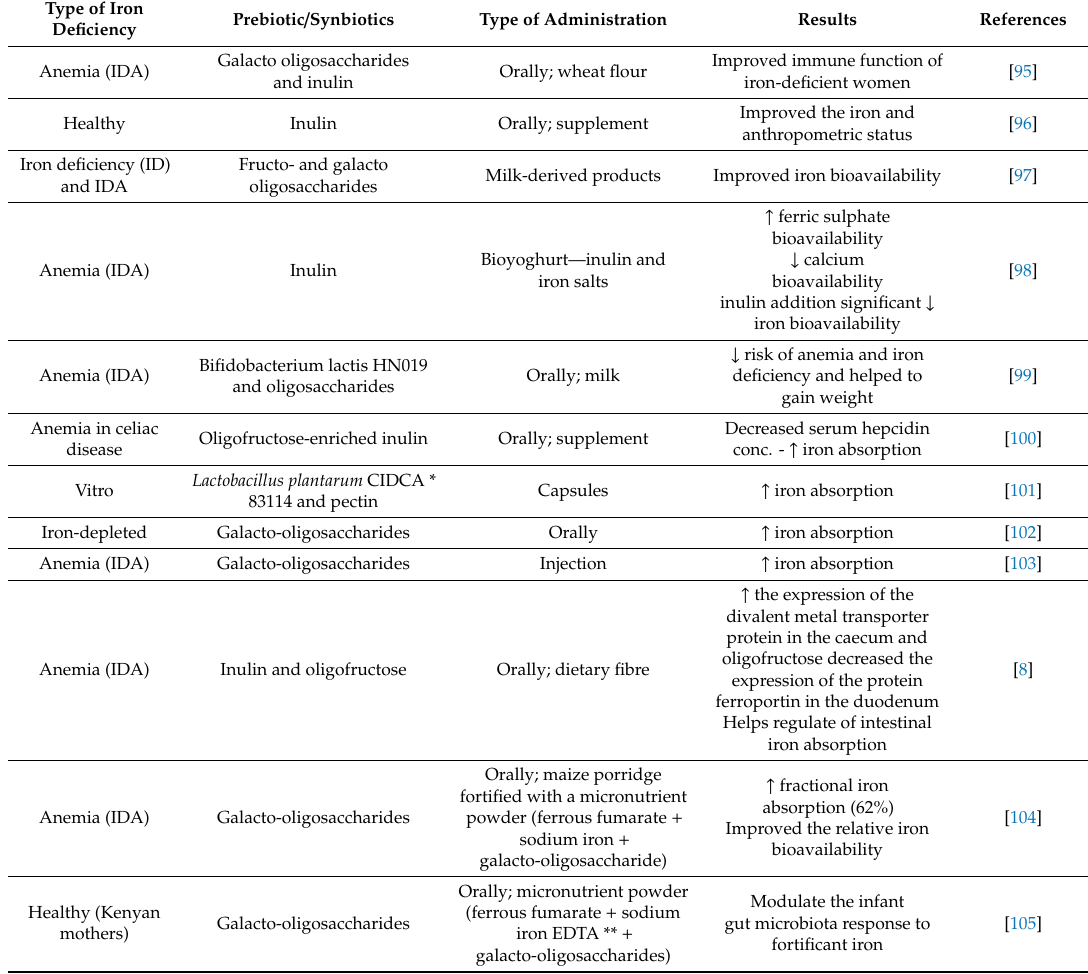
Table 2. Prebiotic and synbiotic intake in di ff erent types of iron deficiencies and their e ff ect on the iron level in the